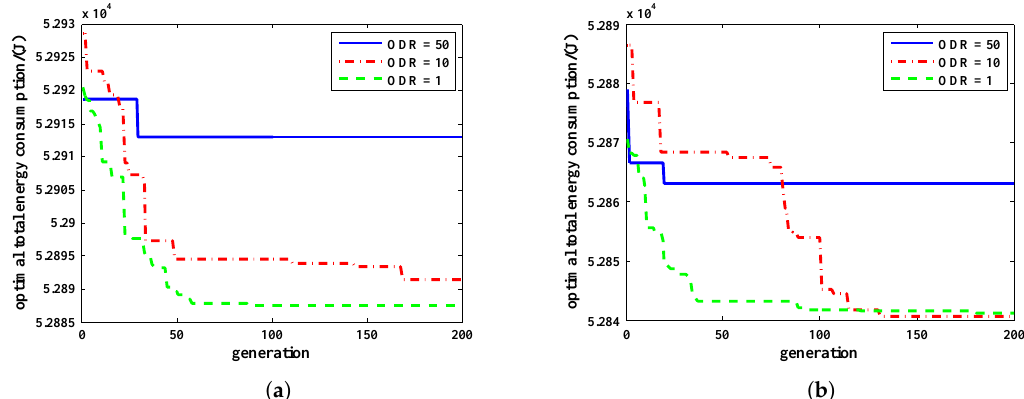
Figure 20. The optimal result of different ODR in the equator area. Panel ( a ) shows the optimal result in summer where the total energy consumption reduced by 11.9% and ( b ) shows the optimal result in winter where the total energy consumption reduced by 11.8%.